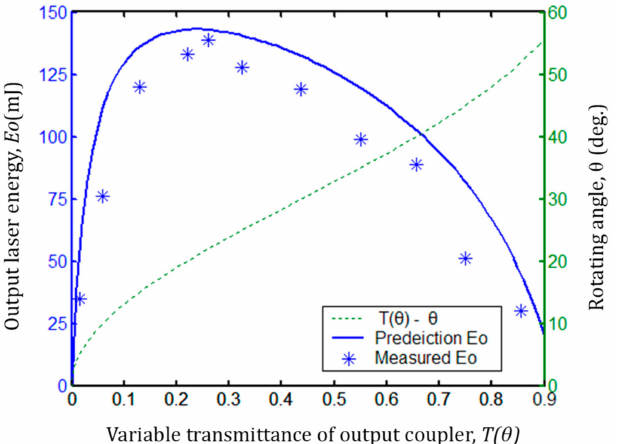
Figure 10. The predicted output curve of E O and the measured values of E O as functions of the variable transmittances T ( θ ) of the output coupler, and the variable transmittances T ( θ ) with respect to the rotating angle θ